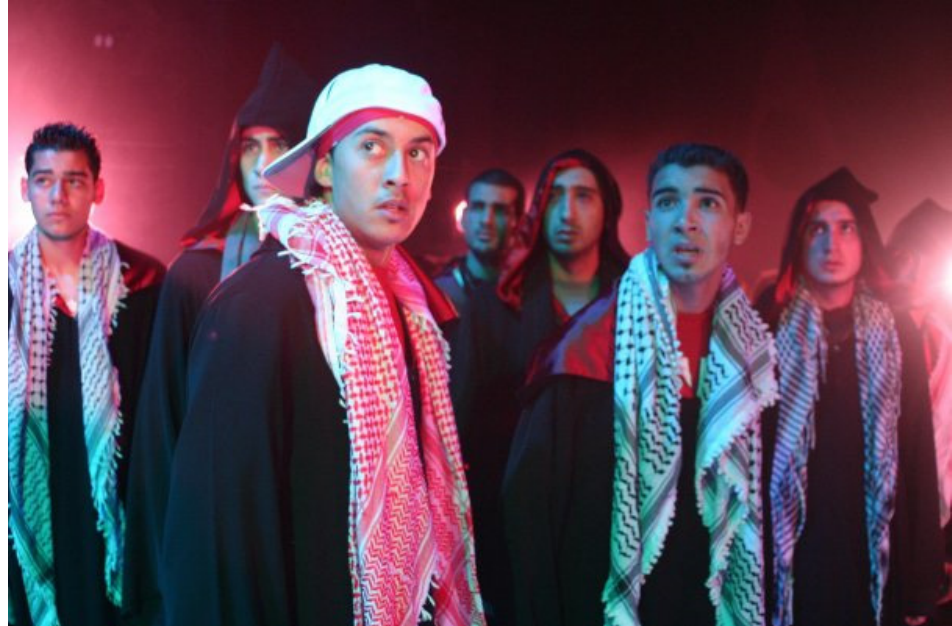
Figure 1. The chorus of Hamlet in El-Basha’s production comprising a group of eight actors who collectively speak most of Hamlet’s lines. Photo: Akram Safadi. Courtesy of Kamel El-Basha and the Al-Hakawati Palestinian National Theatre.